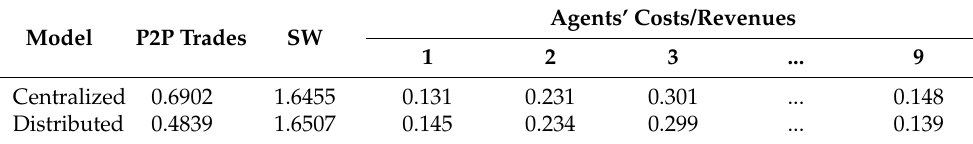
Table 2. Community P2P trades, social welfare, and agents’ costs/revenues for both centralized and distributed models.